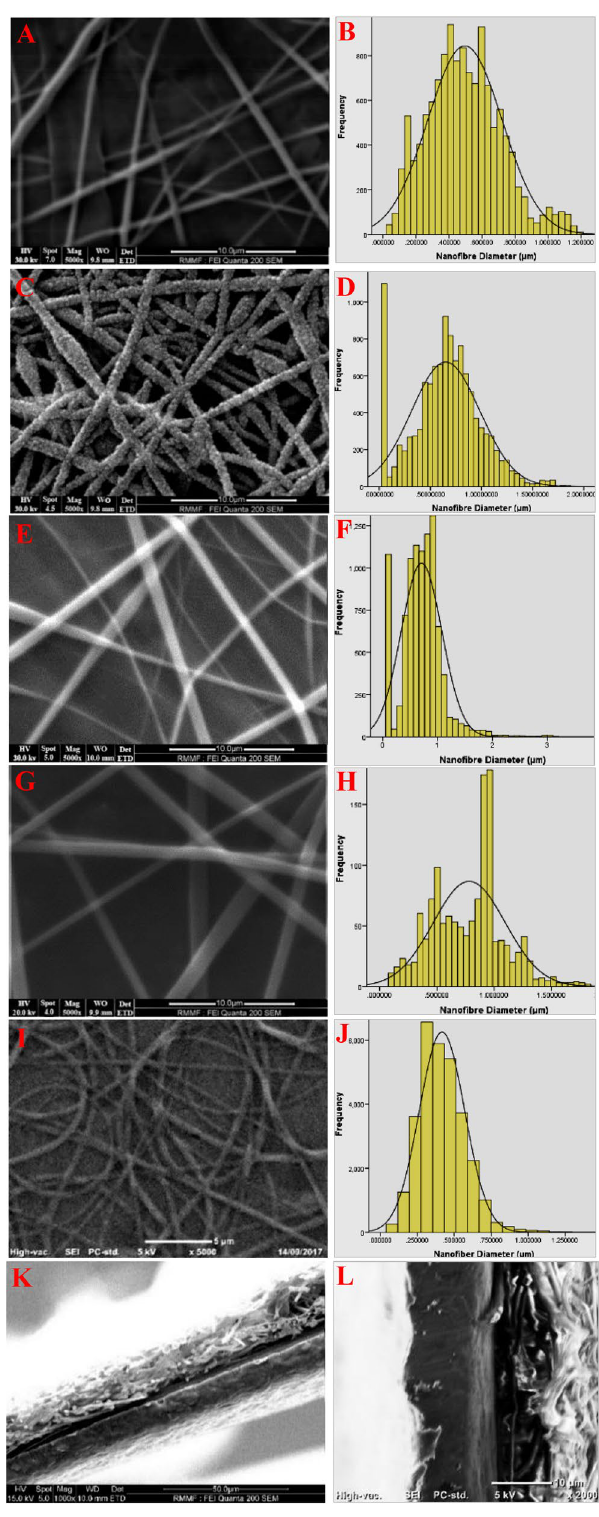
Figure 1. SEM images and related diameter histograms of PLLA electrospun nanofibres containing urea at concentrations of 0% *( A , B ), 10% **( C , D ), 20% *( E , F ), and 40% *( G , H ). SEM images and diameter distribution of 7% PHB electrospun nanofibres ( I , J ). SEM image of cross section of PHB/PLLA/PHB triple-layer nanofibrous structure containing 10% urea at ( K ) 1000 × magnification, and ( L ) 2000 × magnification. * Gold coating** Carbon